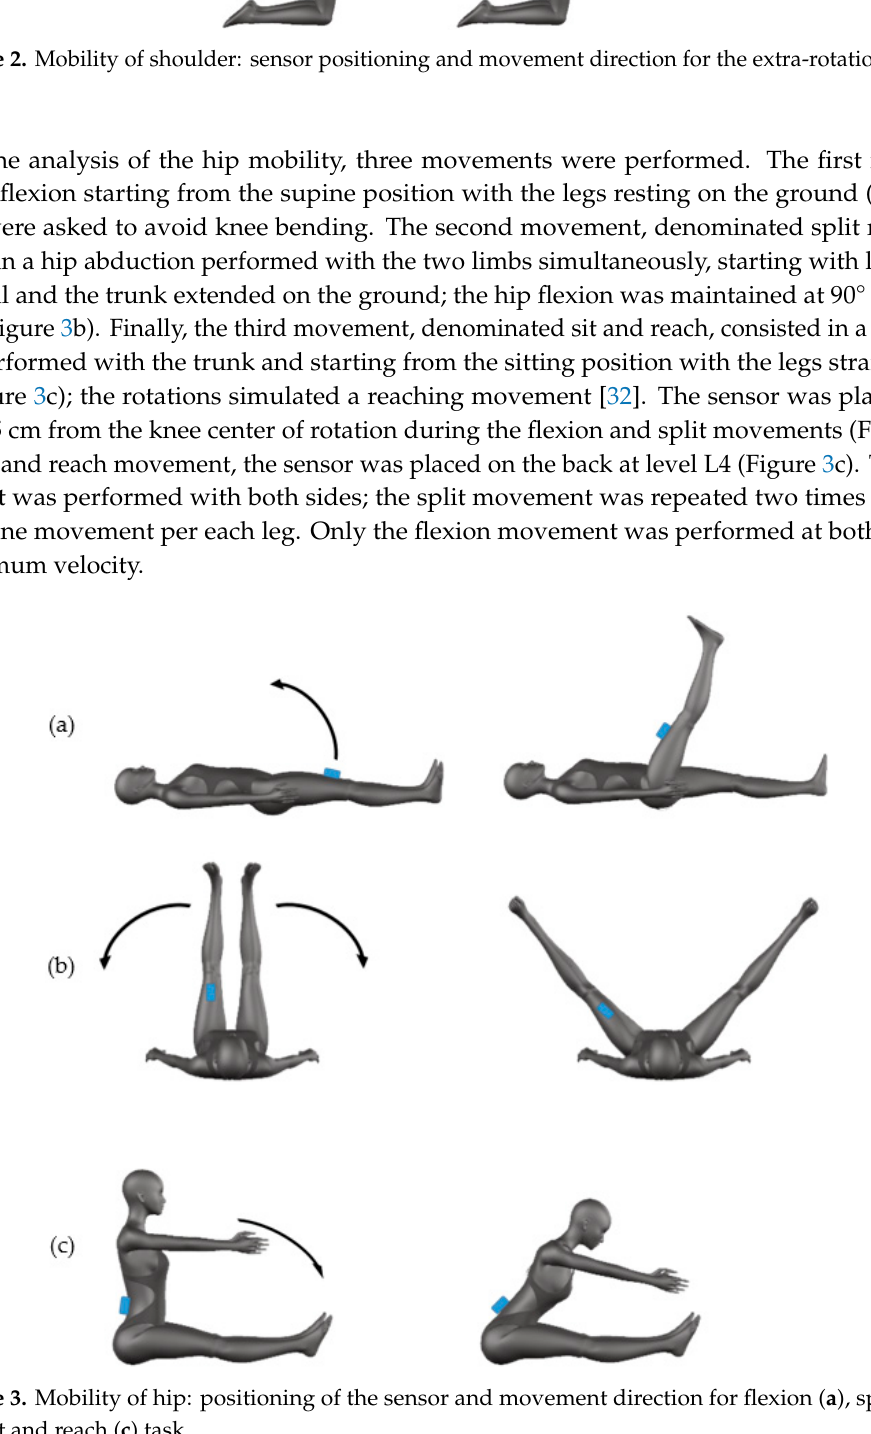
Figure 3. Mobility of hip: positioning of the sensor and movement direction for flexion ( a ), split ( b ), and sit and reach ( c )